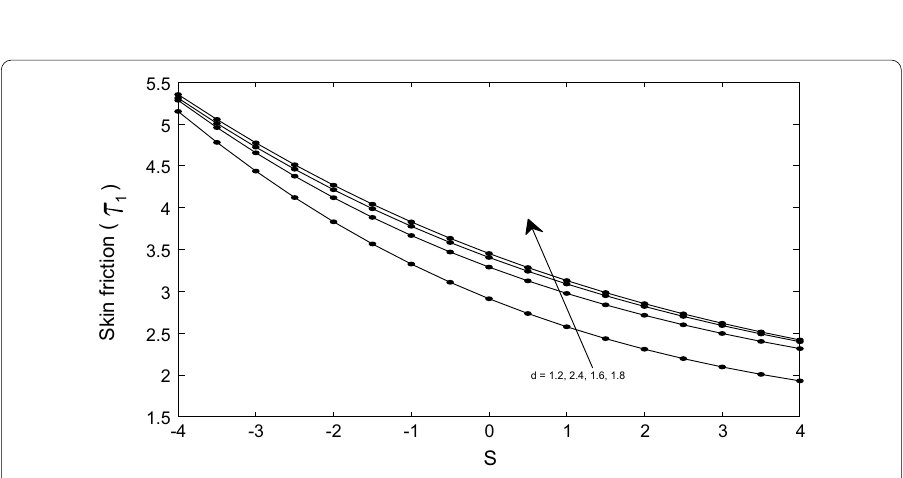
0.2, β 0.2, P 10, A ∗ 1, w 0.8 ) = = − = = =